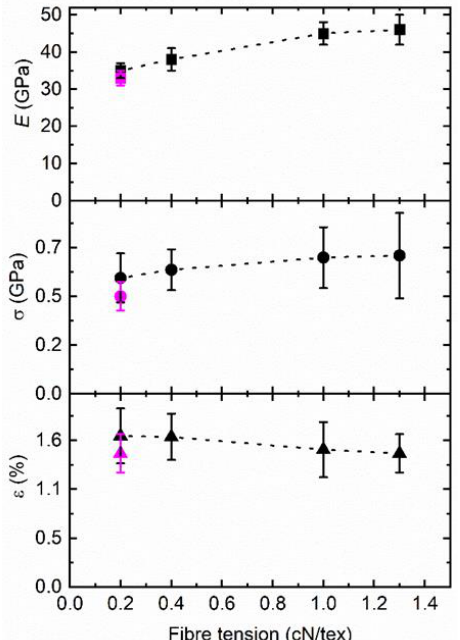
Figure 11. Effect of fiber tension during carbonization on the tensile properties of CFs made by continuous conversion of System P precursors. Black: 0 wt% lignin; purple: 30 wt% lignin. For all samples, a residence time of 10 min was used except when using a tension of 1.3 cN/tex, where 20 min was used. E = Young’s modulus; σ = tensile strength; ε = elongation at break.